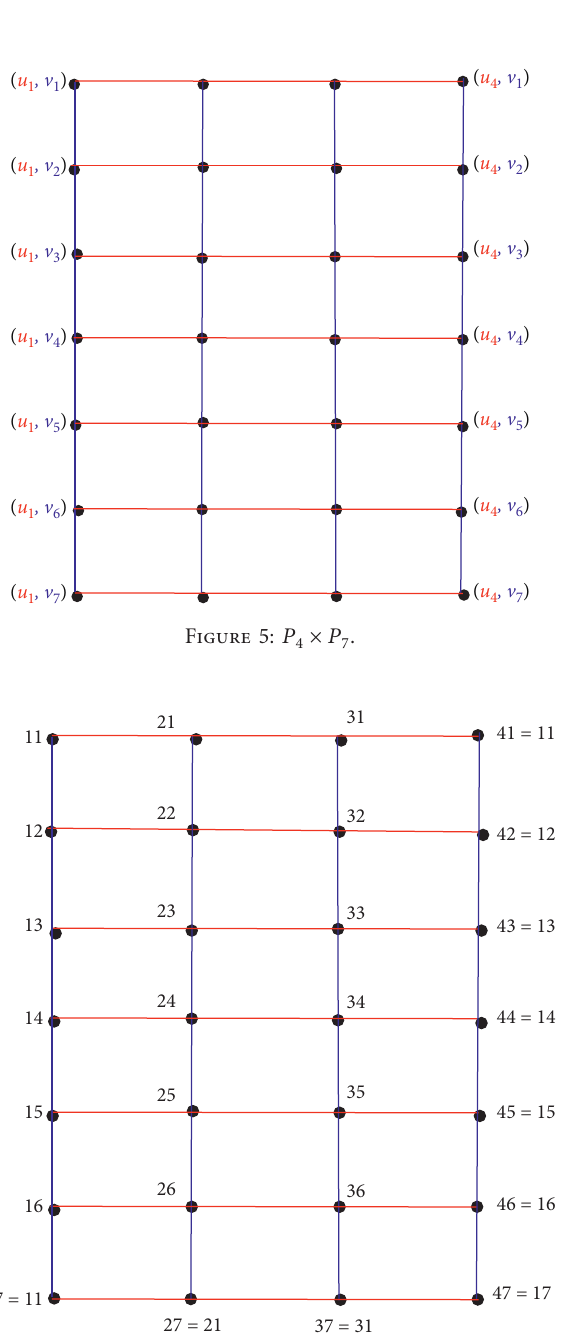
Figure 6: Grid form of T